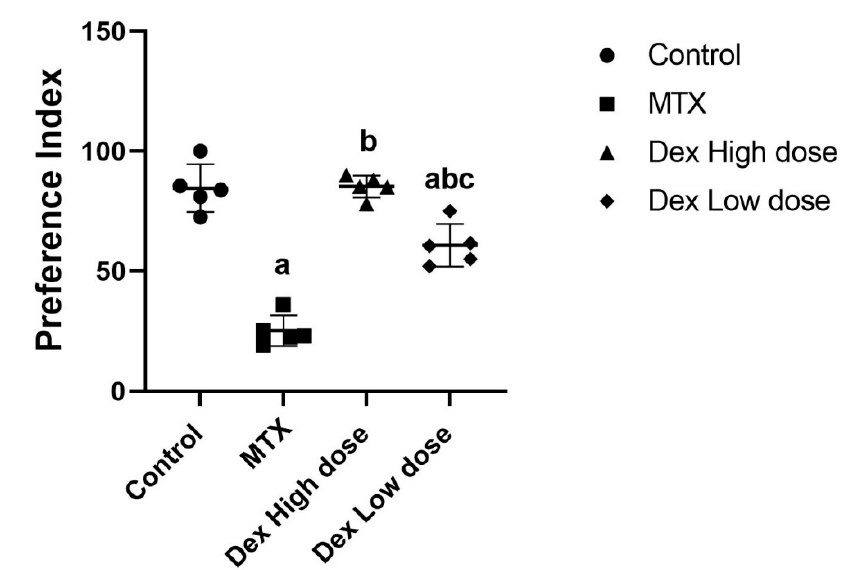
Figure 10. Cognitive and behavioral analysis for the pilot study. Preference index (PI) shows lower preference for the novel object in the MTX group compared to other groups. The pilot study also reveals higher PI in the high dose of Dex co-treatment compared to the low dose of Dex. Data are expressed as mean ± SD, n = 5. (a) Significant difference from control, (b) significant difference from MTX, and (c) significant difference from high dose of Dex. Significance level is set at p < 0.05. One-way ANOVA followed by Tukey’s post hoc test were used in the statistical analysis.